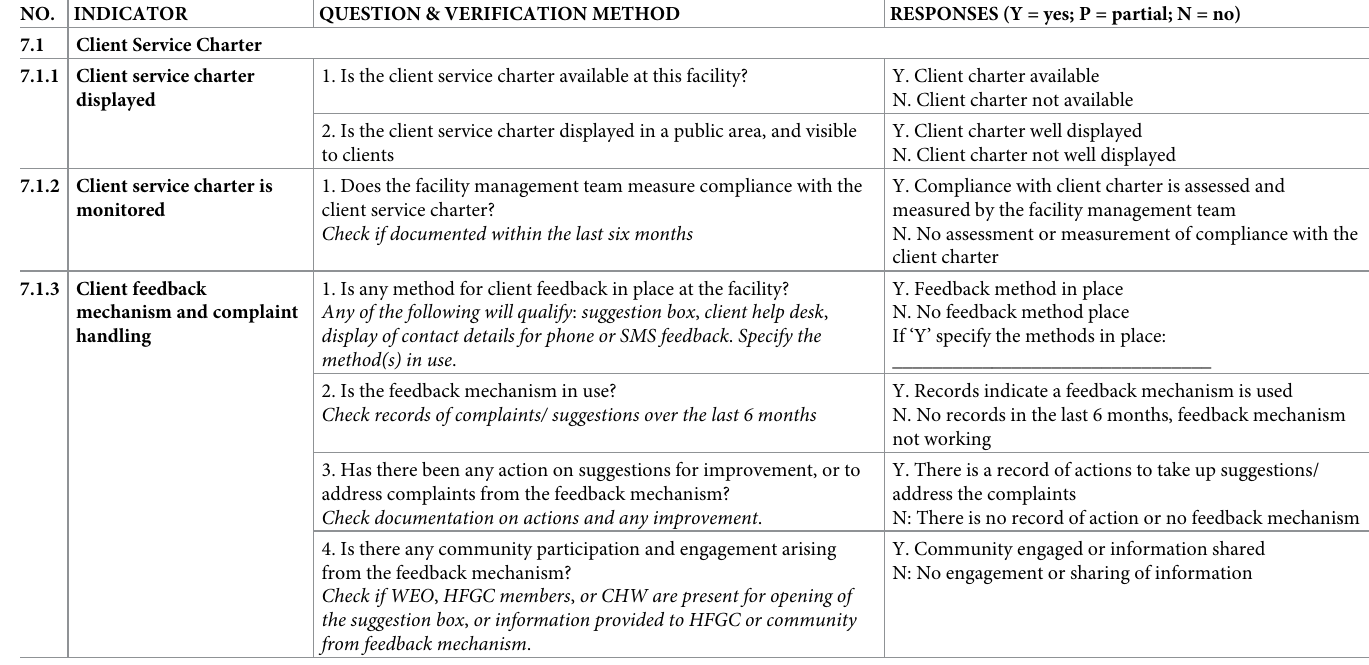
Table 3. Assessment criteria and scoring scale for client service charter indicators during SRA